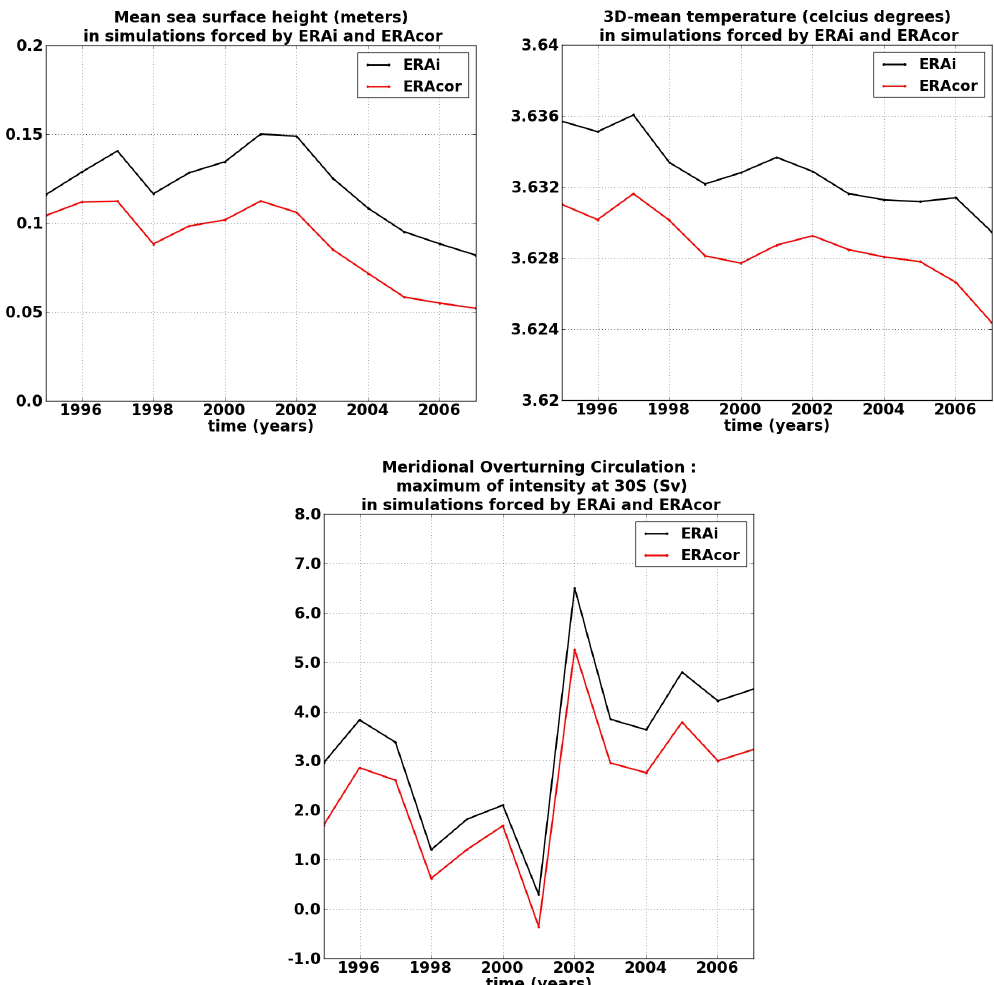
Fig. 12. Comparison between the simulations forced by ERAi (black) and ERAcor (red). Top: time series between 1995 and 2007 of the global mean of the sea surface height in m (left), and of the global mean of the temperature in ◦ C (right). Bottom: time series between 1995 and 2007 of the maximum intensity of the meridional overturning circulation at 30 ◦ S in